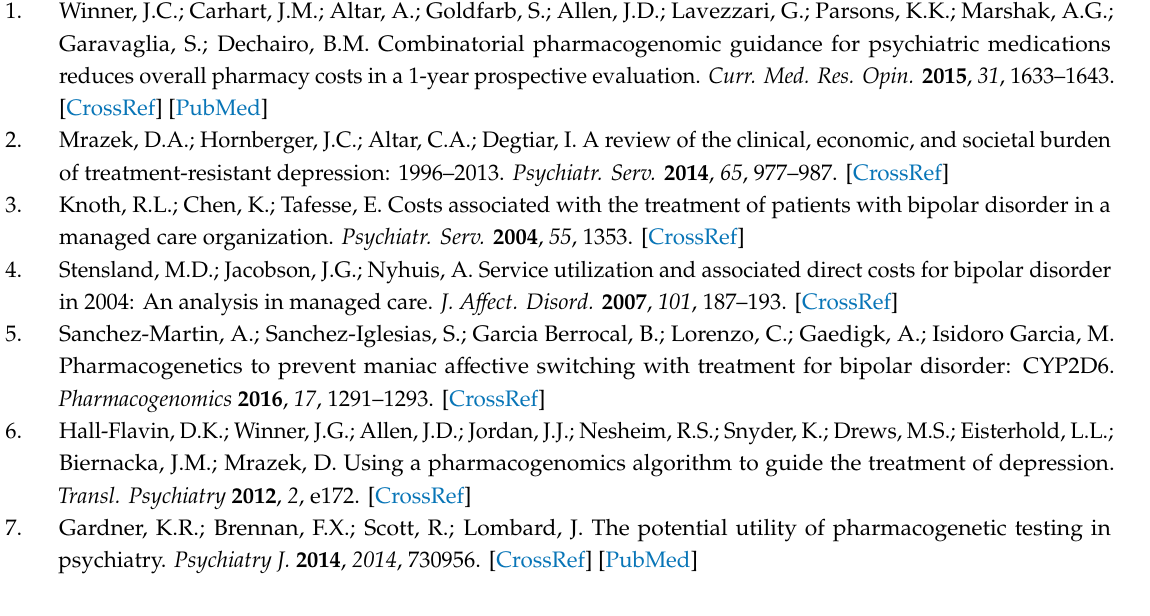
Figure S1: Portale software; Table S1: List of genes and polymorphisms analyzed. Author Contributions: C.C. and M.I. did the protocol, the first draft and supervised the entire process; I.C. did